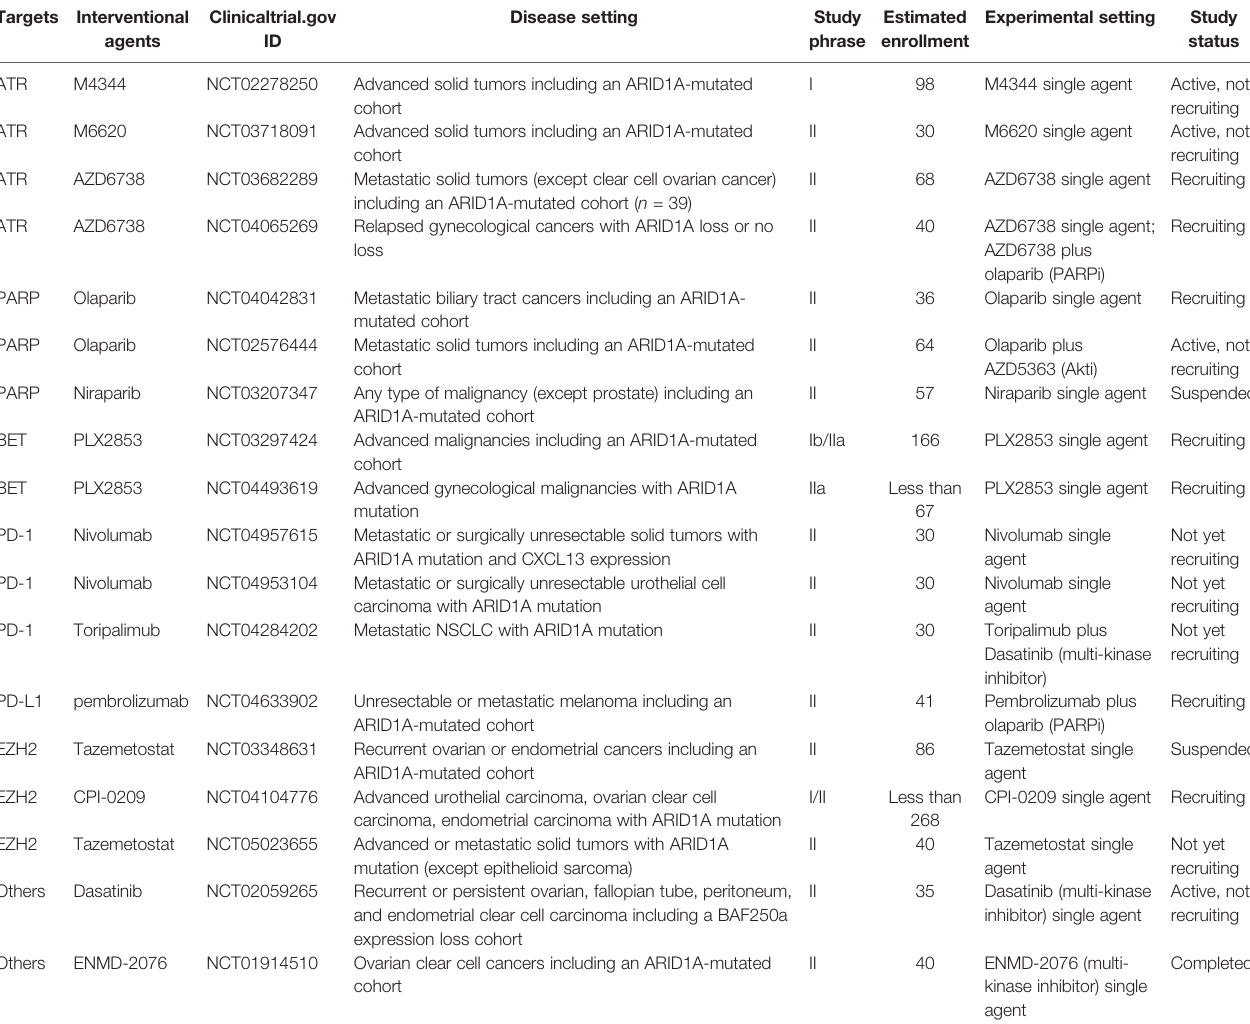
TABLE 1 | Clinical trials involving patients with ARID1A-mutated cancer. Targets Interventional